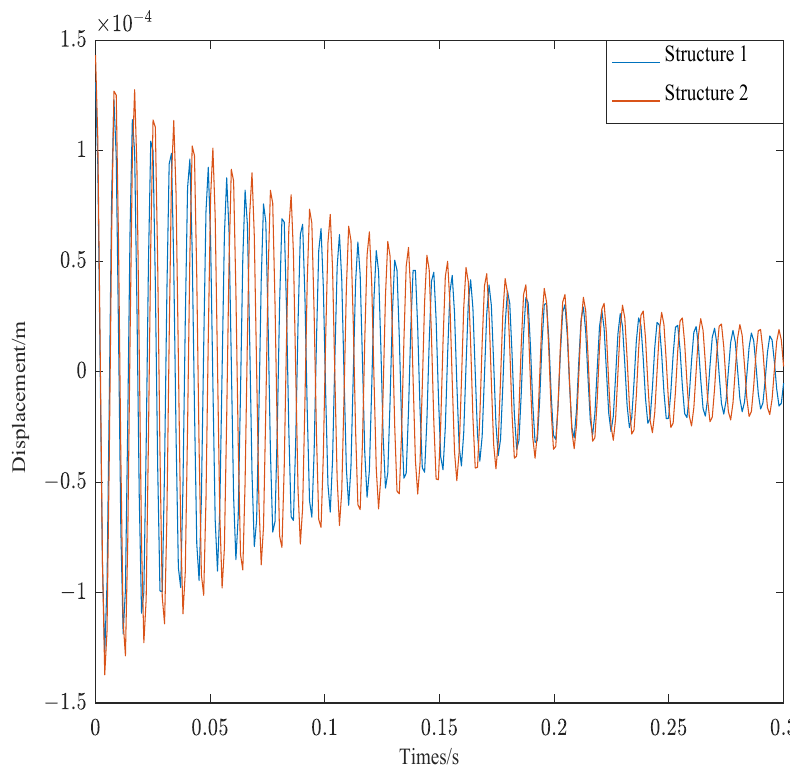
Figure 9. Displacement of structure 1 and structure 2.